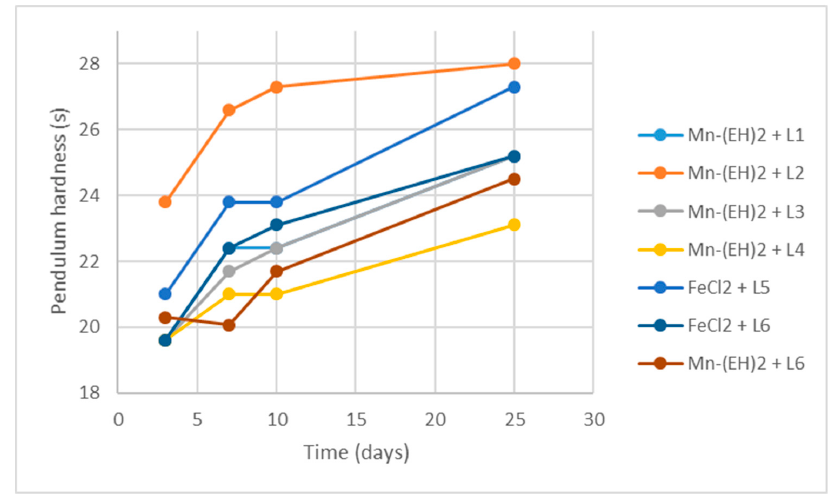
Figure 16. Hardening data in a commercial white alkyd formulation (without optimization using, i.e., secondary and sacrificial siccatives).